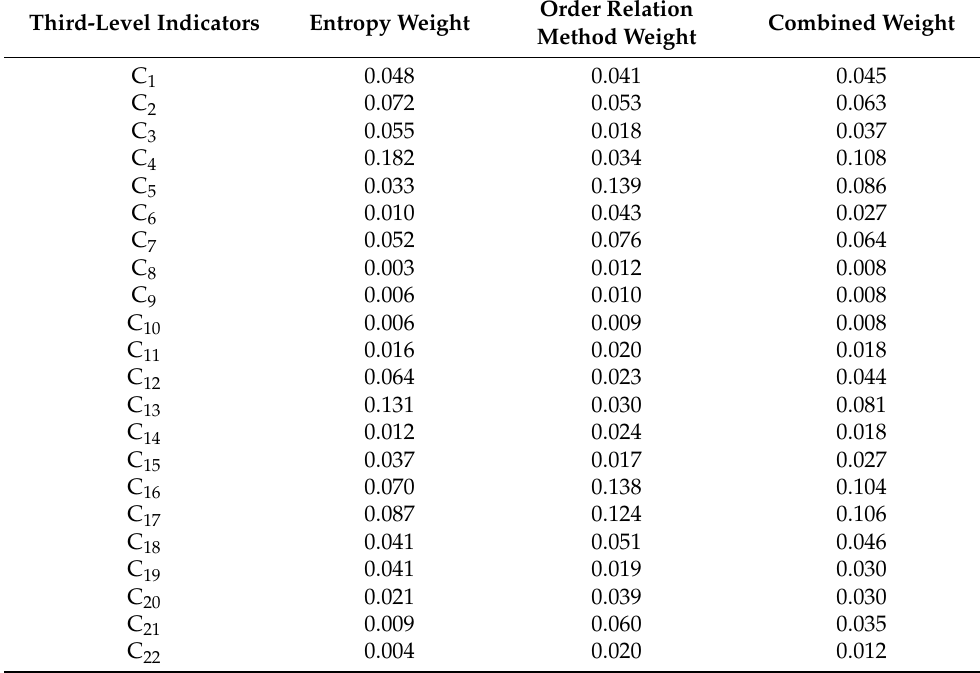
Table 5. Comprehensive weight